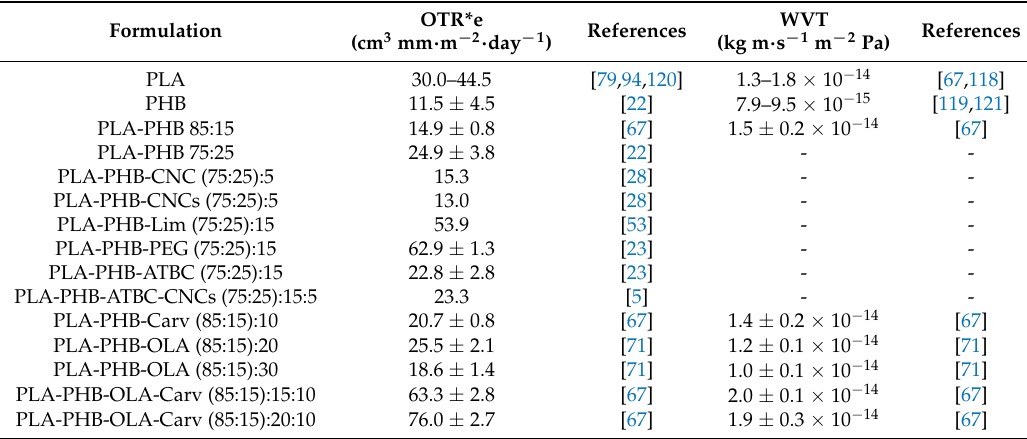
Table 2. Oxygen barrier performance and Water Vapor Transmission (WVT) values of several PLA-PHB based